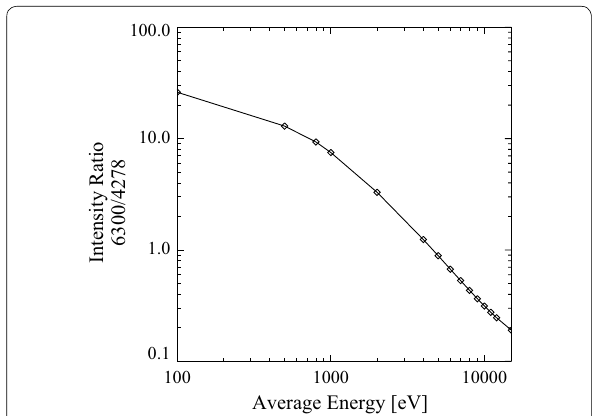
Fig. 1 Intensity ratio of the emission intensity at 630.0 nm to that at 427.8 nm; a model calculation of the intensity ratio of the emission intensity at 630.0 nm to the emission intensity at 427.8 nm versus the average energy of incident